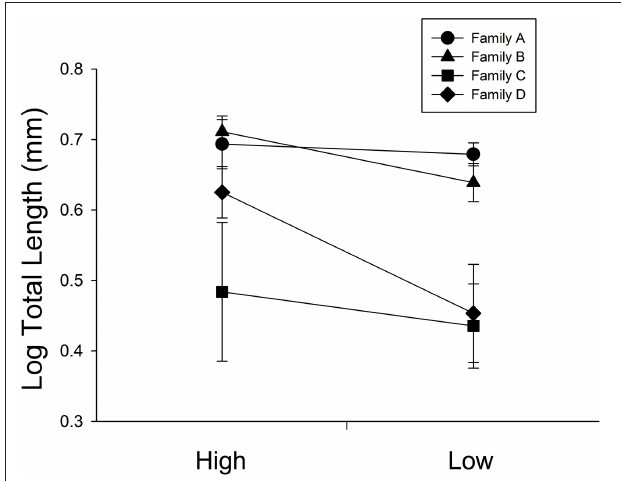
Table 1 ). Variation in swim performance for families A and B remained consistent across diet treatments. Families C and